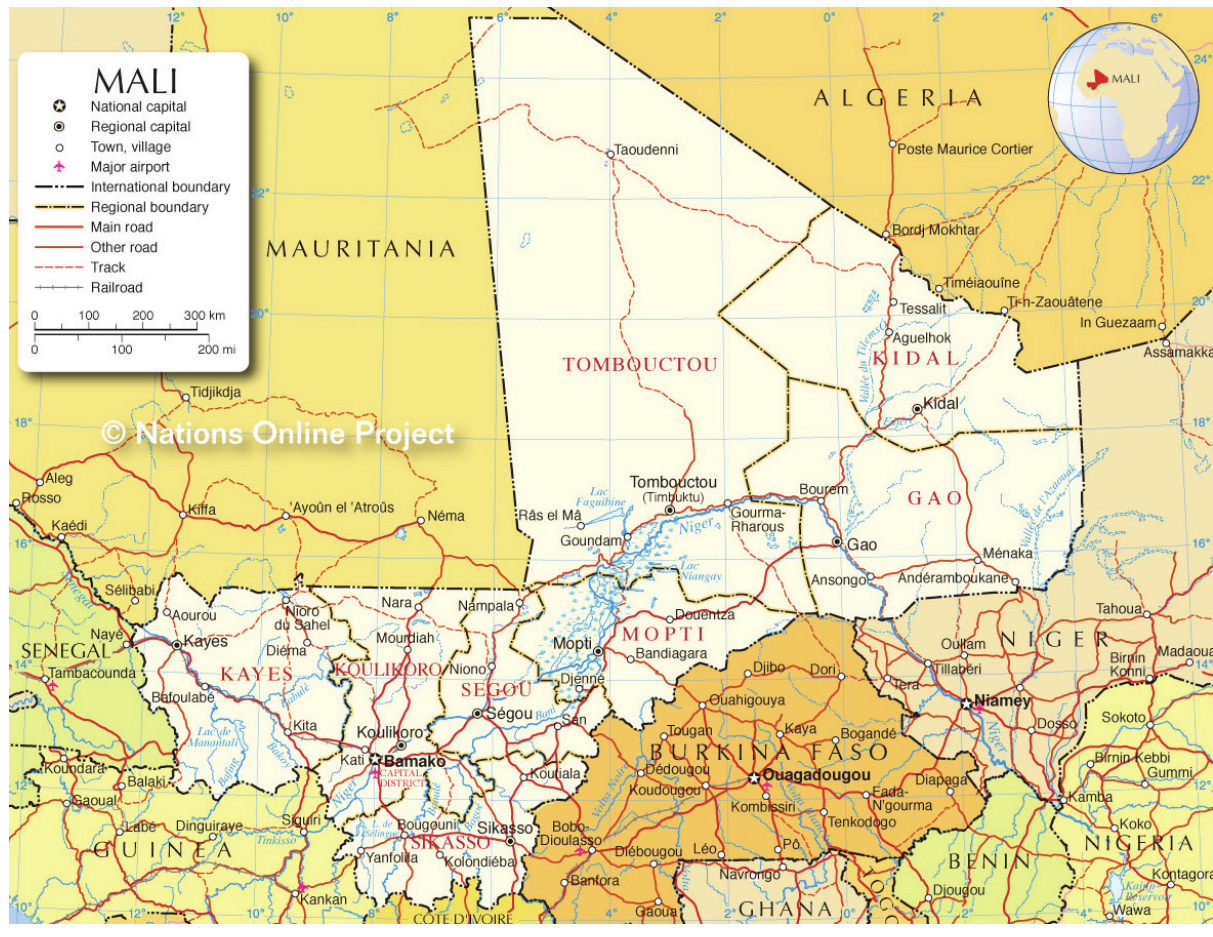
Figure 1. Map of